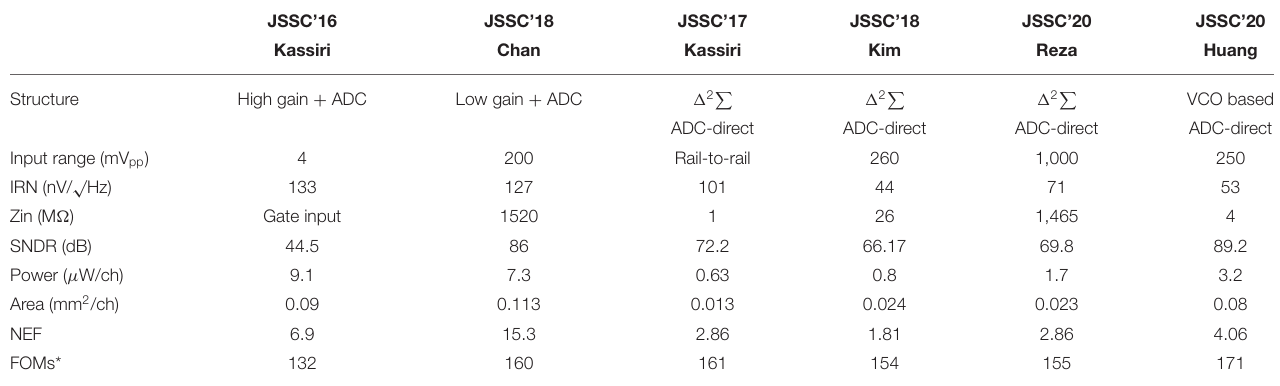
TABLE 2 | Metric comparison with